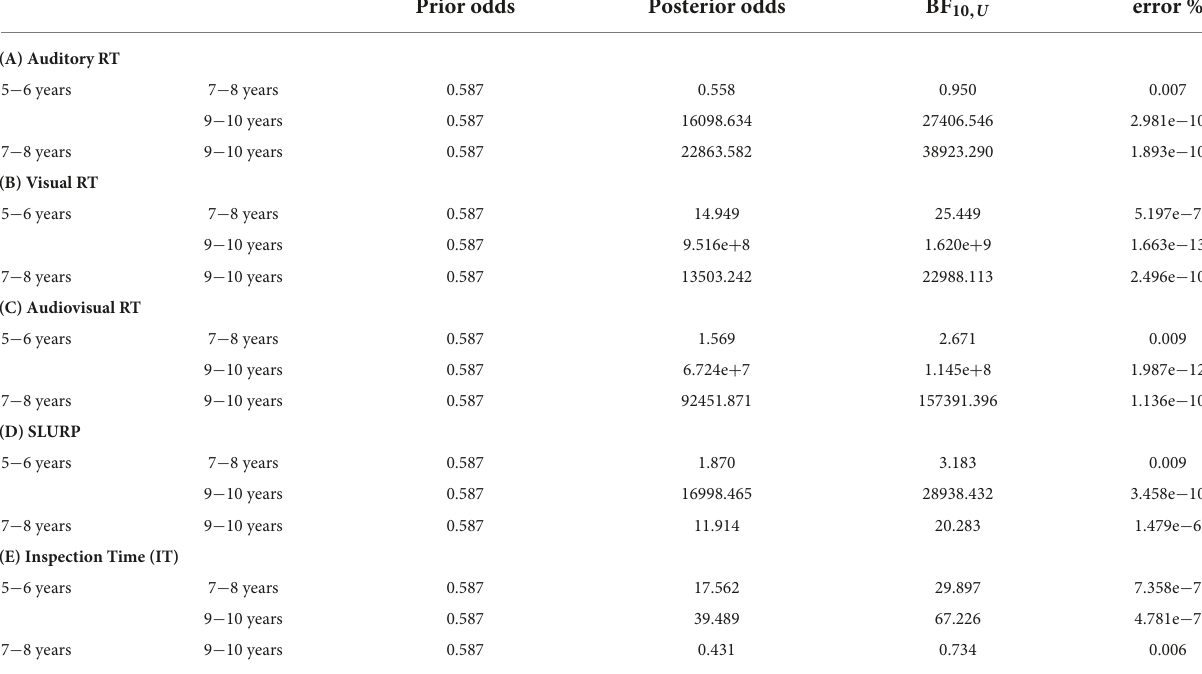
Prior odds Posterior odds BF 10 , U error